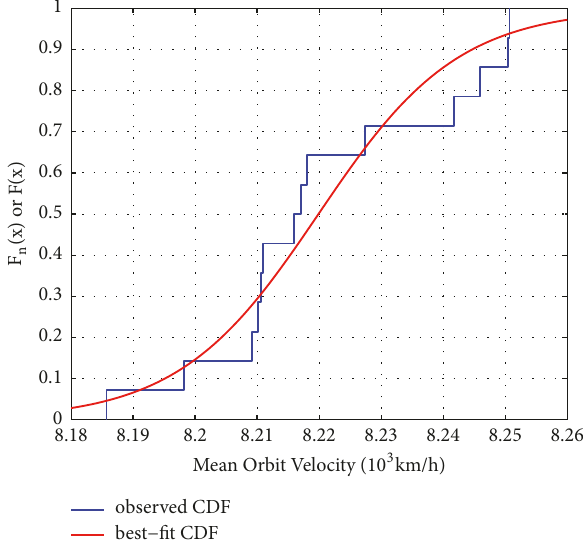
Figure 11: Comparison of the observed CDF and best-fit CDF of mean orbit